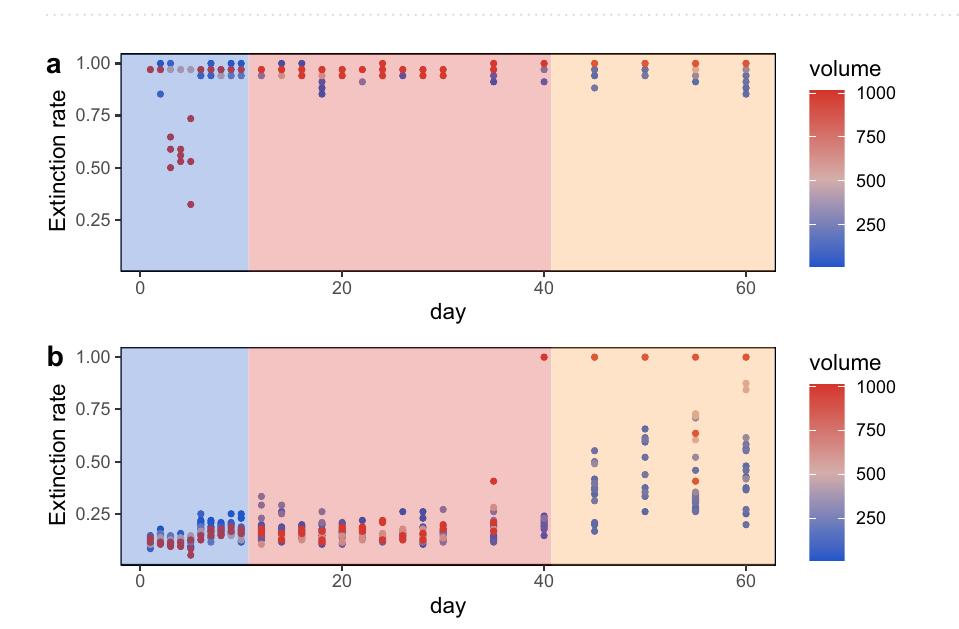
Figure 5. ( a ) Differences in alpha diversity based on the Shannon index (Wilcoxon rank sum test, p < 0.0001). ( b ) NMDS analysis based on Bray–Curtis dissimilarity, showing differentiation in Phases 1–3 (stress = 0.0086).